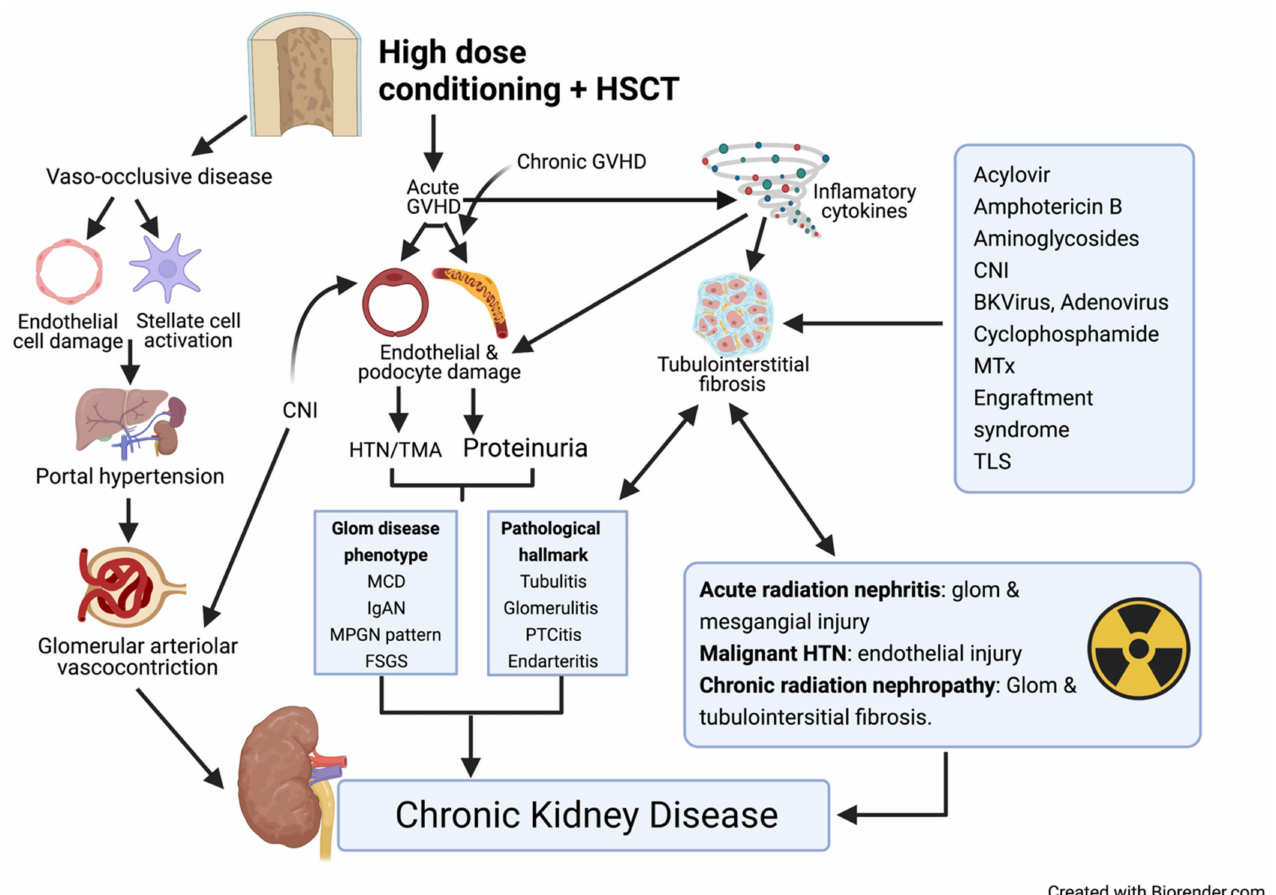
Figure 3. Pathogenesis of HSCT-associated AKI. HSCT = hematopoietic stem cell transplant, GVHD = graft vs. host disease, Glom = glomerular, MCD = minimal change disease, IgAN = IgA nephropathy, MPGN = membranoproliferative glomerulonephritis, FSGS = focal segmental glomerulosclerosis, PTCitis = peritubular capillaritis, CNI = calcineurin inhibitor, MTx = methotrexate, TLS = tumor lysis syndrome, HTN =